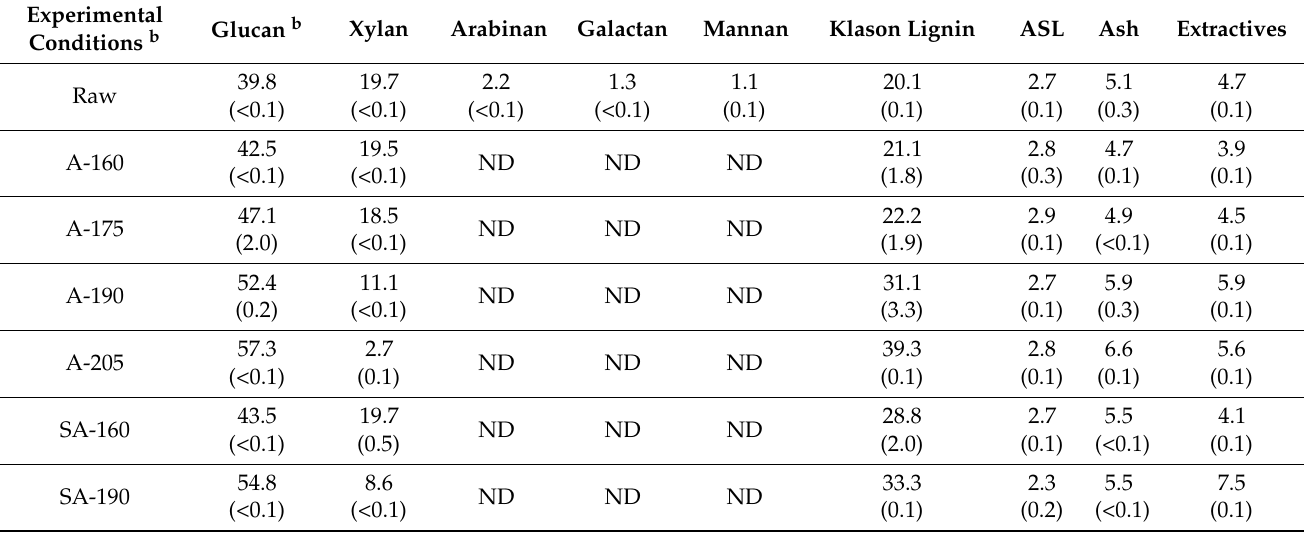
Table 1. Chemical composition of raw wheat straw and pretreated solids, mass fractions in % (dry weight) a . Experimental